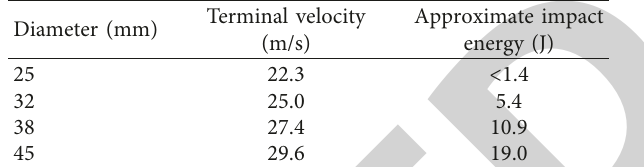
Table 1: Terminal velocity for hailstones of various diameters given by Laurie